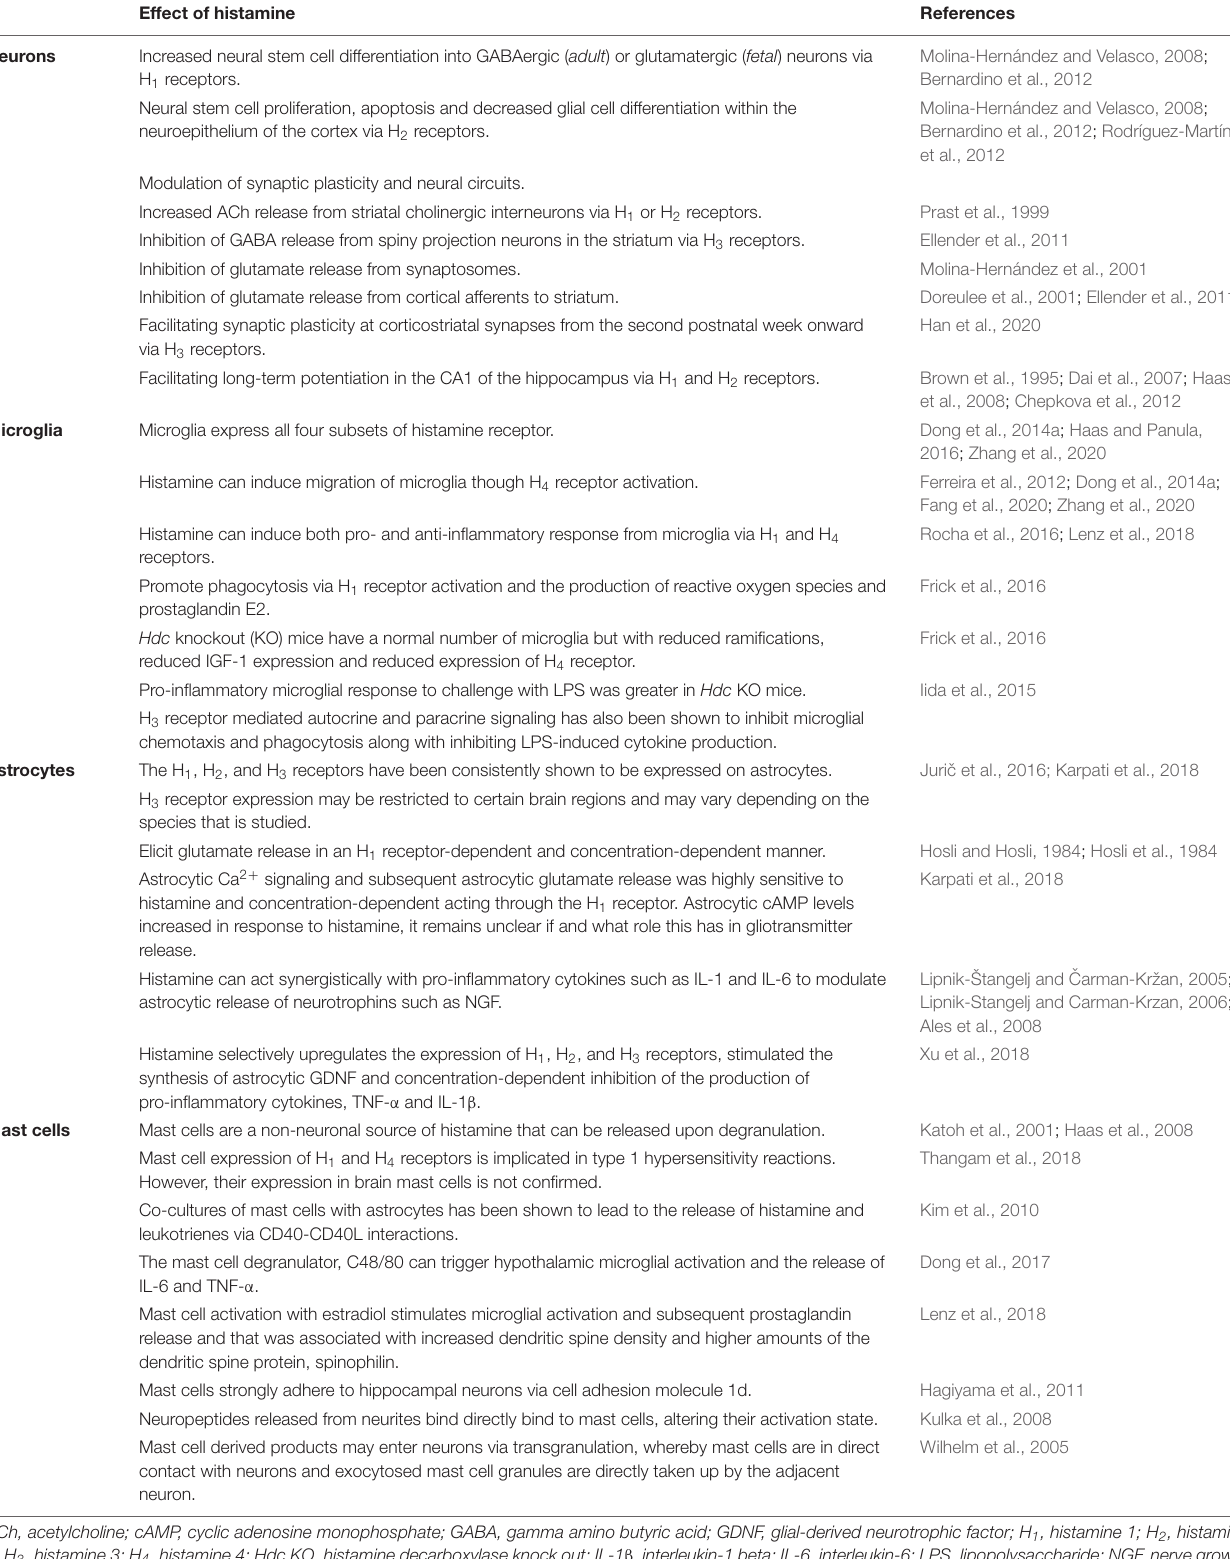
TABLE 1 | Effect of histamine on neurons, microglia, astrocytes and mast cells during early brain development. Effect of histamine